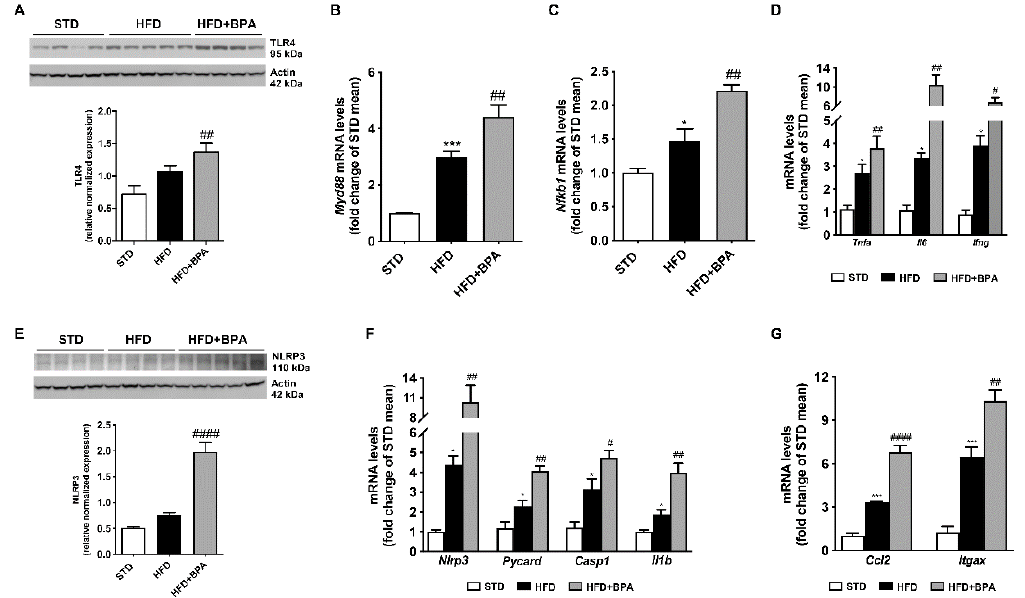
Figure 4. BPA amplifies immune response and cytokine transcription and induces inflammasome activation in the liver of HFD mice. Protein expression of ( A ) TLR4 and mRNA levels of ( B ) Myd88 , and ( C ) Nfkb1 were determined in the liver from all mice. mRNA transcript of ( D ) Tnfa , Il6 , and Ifng was measured. The activation of hepatic inflammasome complexes by BPA was shown by the marked increase of ( E ) NLRP3 protein expression, and the upregulation of ( F ) Nlrp3 , Casp1 , Pycard , and Il1b transcripts, evaluated by Western blot and real-time PCR, respectively. Cropped Western blots for TLR4 and NLRP3 were shown. The increase of chemokine-guided monocyte recruitment induced by BPA was demonstrated by the evaluation of mRNA transcription of ( G ) Ccl2 and Itgax . Data are presented as means ± SEM of all animals ( n = 6 each group) (* p < 0.05, and *** p < 0.001 vs. STD; # p < 0.05, ## p < 0.01, and #### p < 0.0001 vs. HFD).